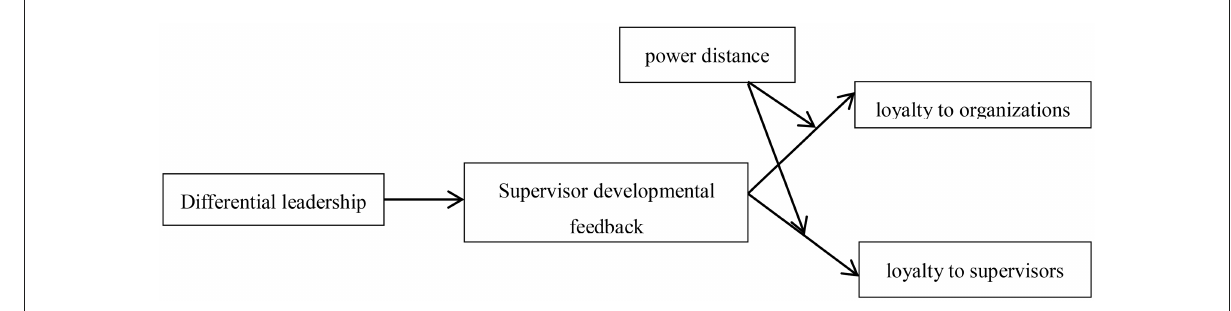
FIGURE 2 Conceptual